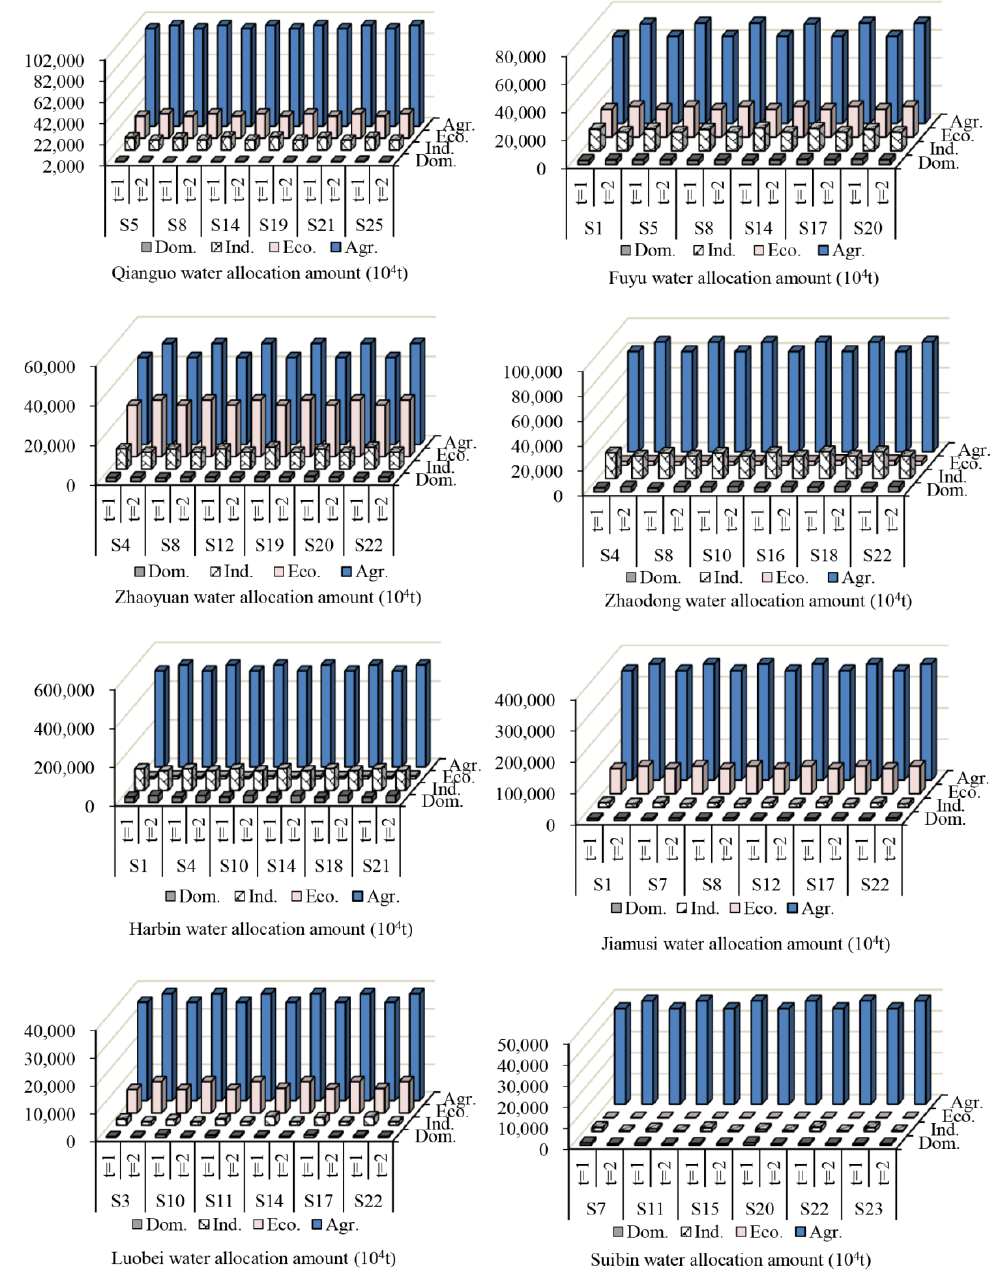
Figure 5. Water allocation in different regions of the study area. Note: Dom. refers to domestic water allocation amount; Ind. refers to industrial water allocation amount; Eco. refers to environmental water allocation amount; Agr. refers to agricultural water allocation amount. Table 7 compared the coefficients of variation for each region and in different periods for different water demand sectors with the 25 scenarios. Notably, in 2020, the water allocation in different sectors was affected by different scenarios, and the fluctuation in 2030 was smaller. In 2020, the domestic water allocation in Luobei was most affected by these different scenarios, while Harbin was the least affected by the different scenarios. The coefficient of variation of the industrial water